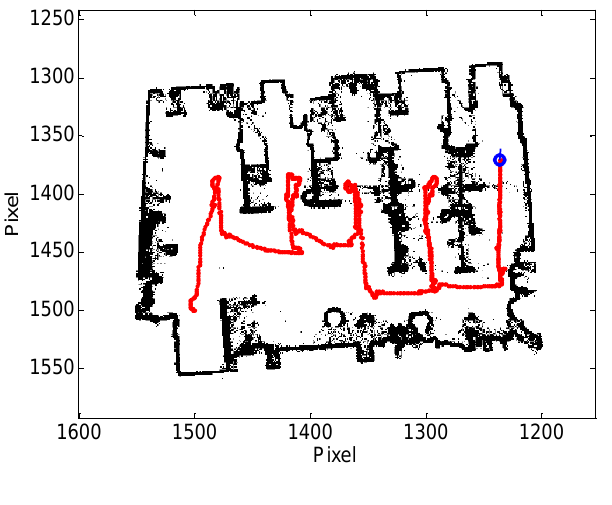
Figure 2. Binary map example obtained in one laboratory, exploration path (red line); robot current position in